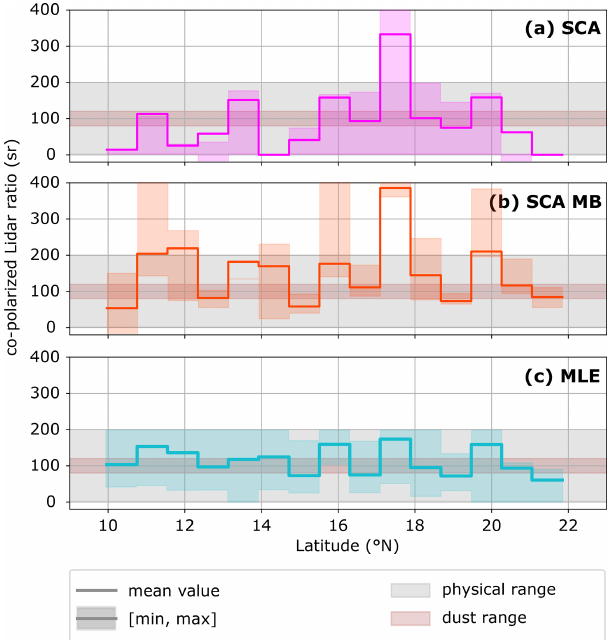
Figure 7. Real data case I: averaged co-polarized lidar ratios ac- cording to (cid:104) α p (cid:105) / (cid:104) β || ,p (cid:105) along the Aeolus ground track, calculated from the 4 × 15 bins (altitude × latitude) within the white box in Fig. 6. Applied algorithms (from top to bottom) are (a) the SCA, (b) the midbin and (c) MLE. The shaded colours indicate the range between minimum and maximum lidar ratios for all considered bins in the column. Additionally, the expected range for the co-polarized lidar ratio of dust is indicated in shaded